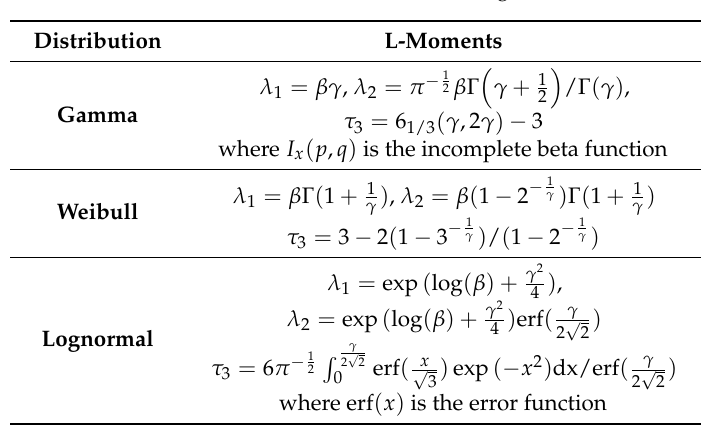
Table A5. L-moments of Gamma, Weibull, and Lognormal distribution.